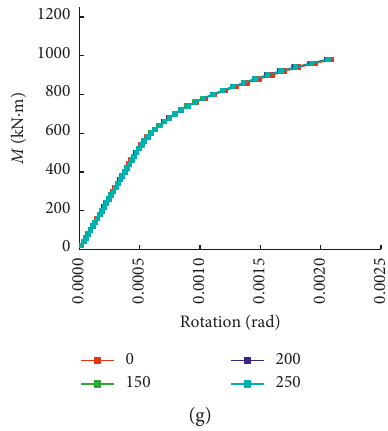
Figure 20: Bending moment-rotation curves of different tenon indentations under axial loads of (a) 500kN, (b) 1000kN, (c) 1500kN, (d) 2000kN, (e) 2500kN, (f) 3000kN, and (g)